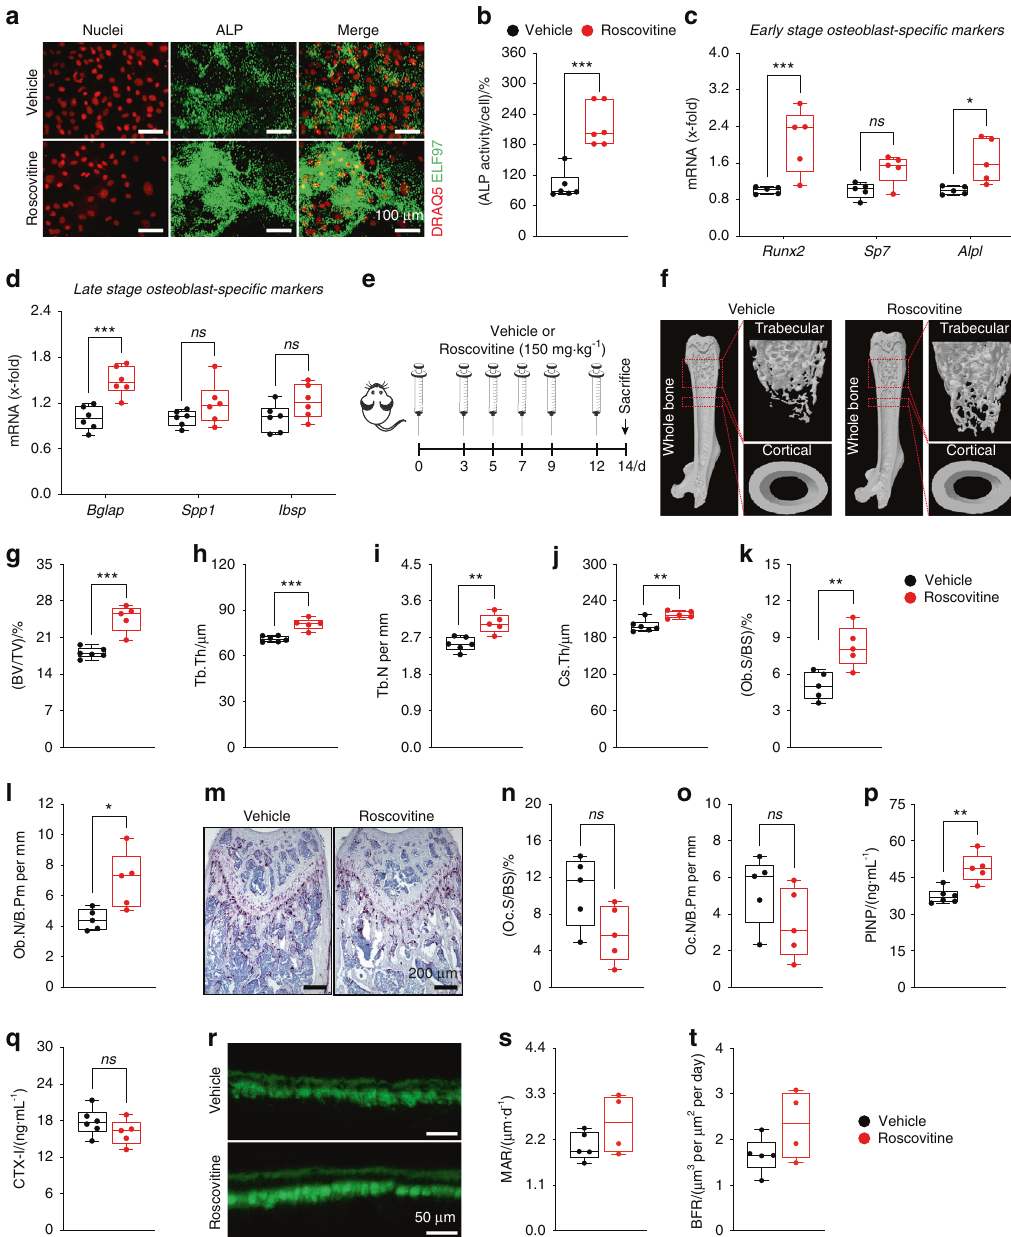
Fig. 3 Roscovitine inhibition of Cdk5 augments in vitro osteoblast differentiation and enhances bone mass in vivo by increasing osteoblastogenesis. a Representative microscopic images showing nuclear and ALP staining in primary murine calvarial osteoblasts with DRAQ5 (red) and ELF97 (green), respectively, upon vehicle or roscovitine (0.16 μ mol·L − 1 ) treatment for 6 days (scale bar: 100 µm). b Quanti fi cation of the percentage of cellular ALP activity in primary murine calvarial osteoblasts upon vehicle or Cdk5 inhibition with roscovitine ( n = 6). c and d qPCR analysis of early-stage ( Runx2, Sp7, Alpl ) and late-stage ( Bglap, Ibsp, Spp1 ) osteoblast-speci fi c marker gene expression in the primary murine calvarial osteoblasts treated with vehicle or roscovitine for 6 and 14 days, respectively ( n = 6). e Experimental setup for the mice treated with vehicle or roscovitine (150 mg·kg − 1 three times per week for 14 days). f Representative microcomputed tomography (micro-CT) images of whole-, trabecular-, and cortical bone of femurs isolated from the vehicle- or roscovitine-treated mice. Calculated trabecular and cortical parameters of femurs from the vehicle- or roscovitine-treated mice that include g percent bone volume - BV/TV (%), h trabecular thickness – Tb.Th (µm), i trabecular number – Tb.N (per mm), j and cross-sectional thickness – Cs.Th (µm) ( n = 5 – 6). Bone histomorphometry was performed in femurs from the vehicle- or roscovitine-treated mice, and the following parameters were calculated from trabecular bone: k percent osteoblast surface per bone surface - Ob.S/BS (%), l and osteoblast number per bone perimeter – Ob.N/B.Pm (per mm). M Representative images of tartrate-resistant acid phosphatase (TRAP) staining for osteoclasts (purple) (scale bar: 200 µm), n osteoclast surface per bone surface – Oc.S/BS (%) and o osteoclast number per bone perimeter – Oc.N/B.Pm (per mm) ( n = 5). Analysis of bone formation and resorption markers p PINP (ng·mL − 1 ) and q CTX-I (ng·mL − 1 ) ( n = 5 – 6). Dynamic bone histomorphometry was performed in femurs from the vehicle- or roscovitine-treated mice, and the following parameters were used: r representative images of dual calcein labeling (green) (scale bar: 50 µm), s mineral apposition rate – MAR/( μ m·d − 1 ), and t bone formation rate – BFR/(µm 3 per µm 2 per day). Data are represented as box-and-whisker plots with min. to max. as well as with superimposition of all the data points. Statistical differences between two groups were determined by unpaired homoscedastic two-tailed Student ’ s t test and two-way ANOVA with Sidak ’ s multiple comparisons test. * P < 0.05, ** P < 0.01, *** P <